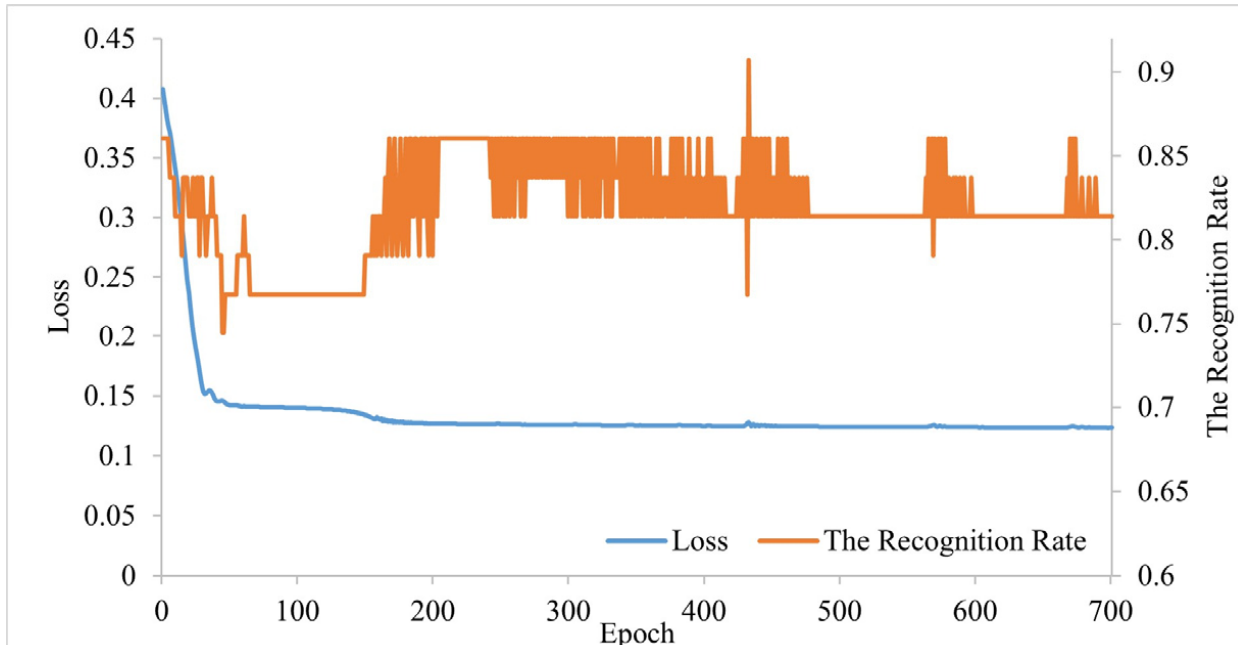
Figure 8. Variation in loss and the recognition rate with number of training epochs. Note that: here we set the threshold of the anomaly score map as median, and the recognition rate is calculated as the ratio of the number of ore spots falling within the anomalous areas to the total number of known ore spots.